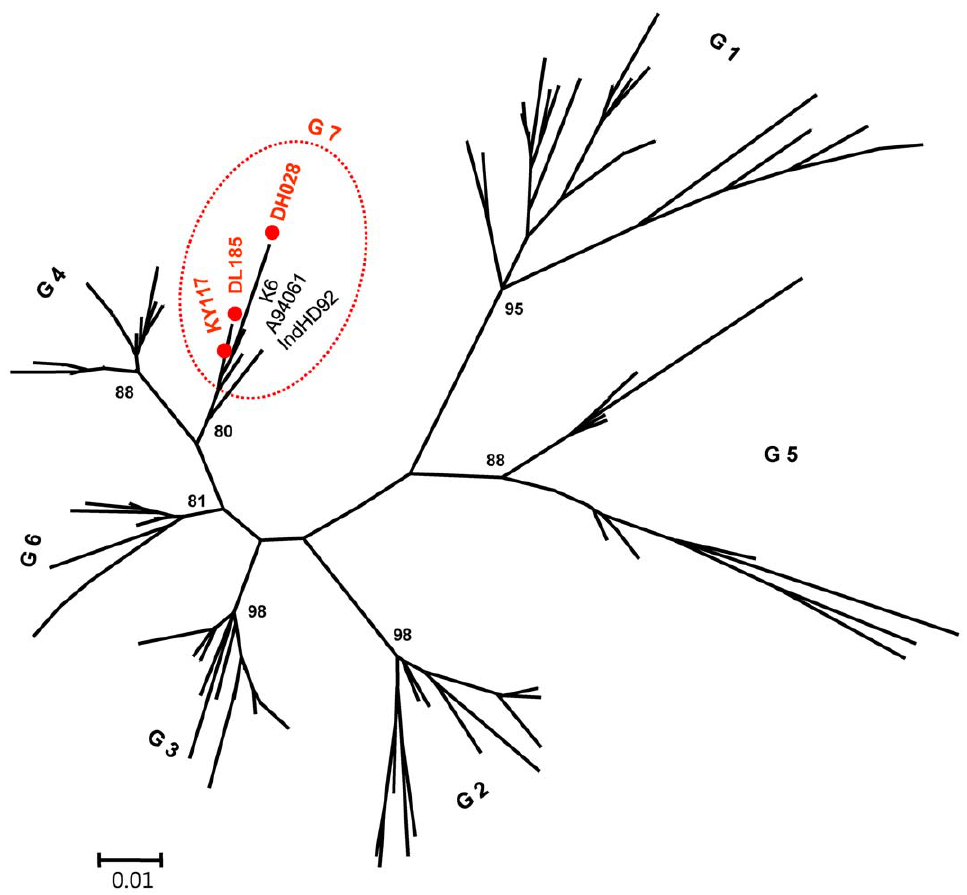
Figure 5. Phylogenetic tree based on partial 5 9 UTR region sequences. These sequences were each 187 nt in length, corresponding to nucleotides -398 , -202 in the genome of GBV-C isolate U36380. The tree was constructed using the Minimum Evolution method. Except for G7, all the isolates were adopted from the previous report by Muerhoff et al. [2006].